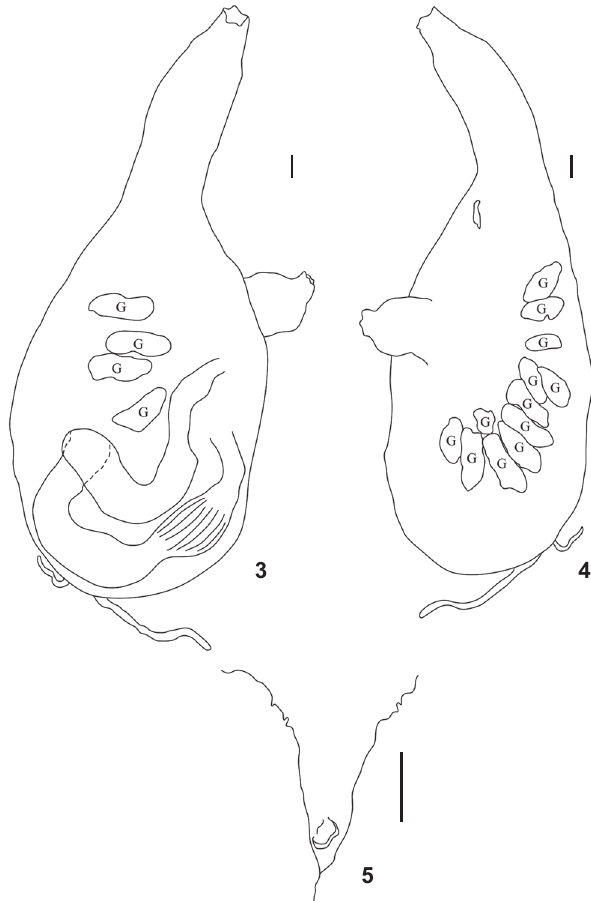
Figure 3-5. Polycarpa cf. reviviscens : (3) individual without tunic, left side; (4) individual without tunic, right side; (5) anterior region with dorsal tubercle. (G) Gonad. Scale bars: 1.0